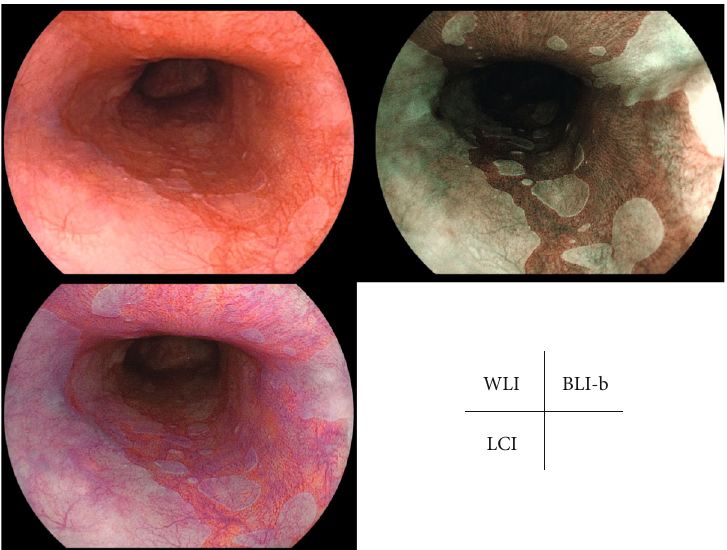
Figure 2: Representative case of long-segment Barrett ’ s esophagus. WLI: white light imaging; LCI: linked color imaging; BLI-b: blue laser imaging bright.